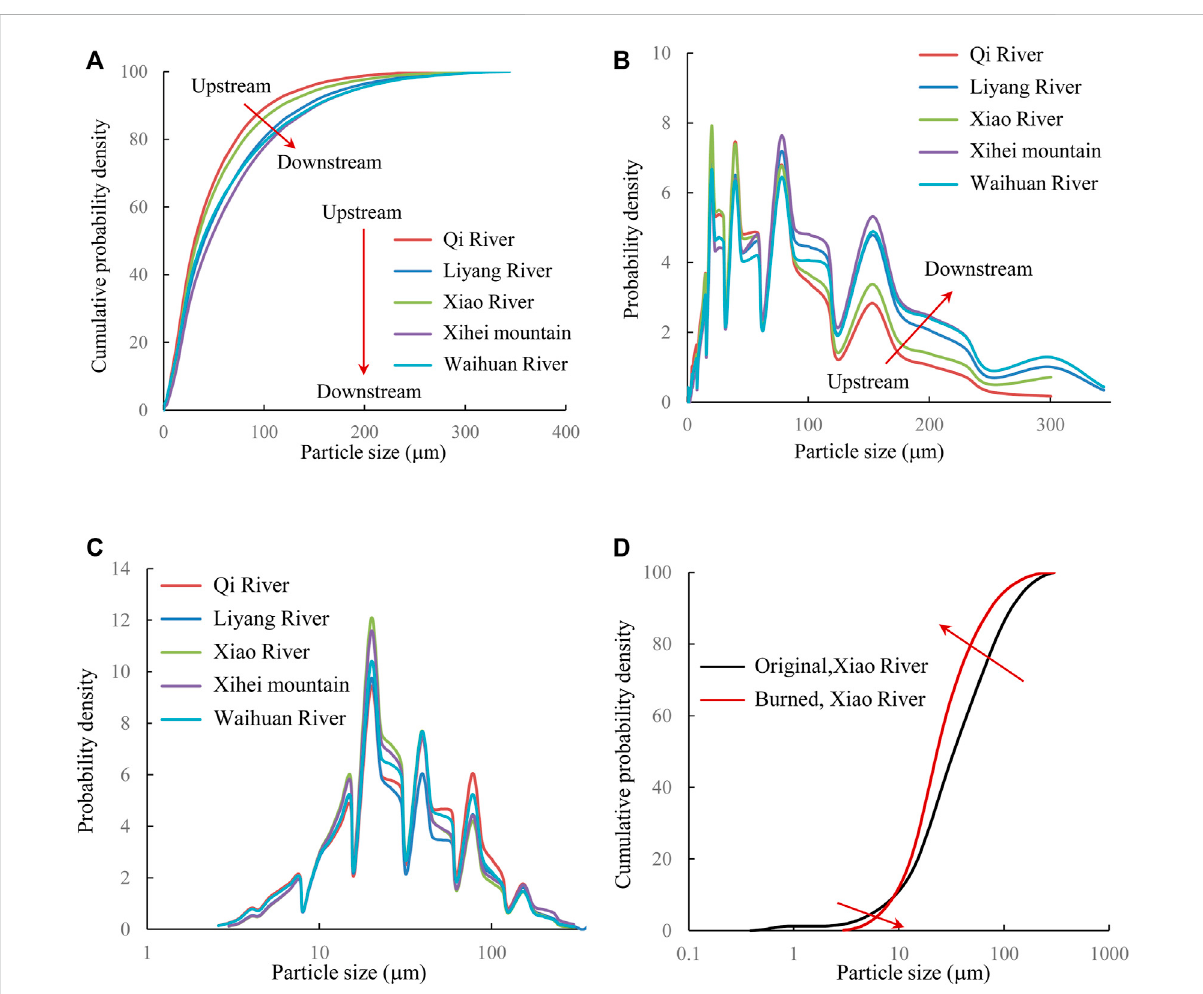
FIGURE 7 Particle size distribution of siltation samples in the MRP. (A) cumulative probability density curves of the diameter of the original samples; (B) probabilitydensitycurvesofthediameteroftheoriginalsamples; (C) probabilitydensitycurvesofthediameteroftheburnedsamples (D) cumulative probability density curves of the original and burned samples at Xiao